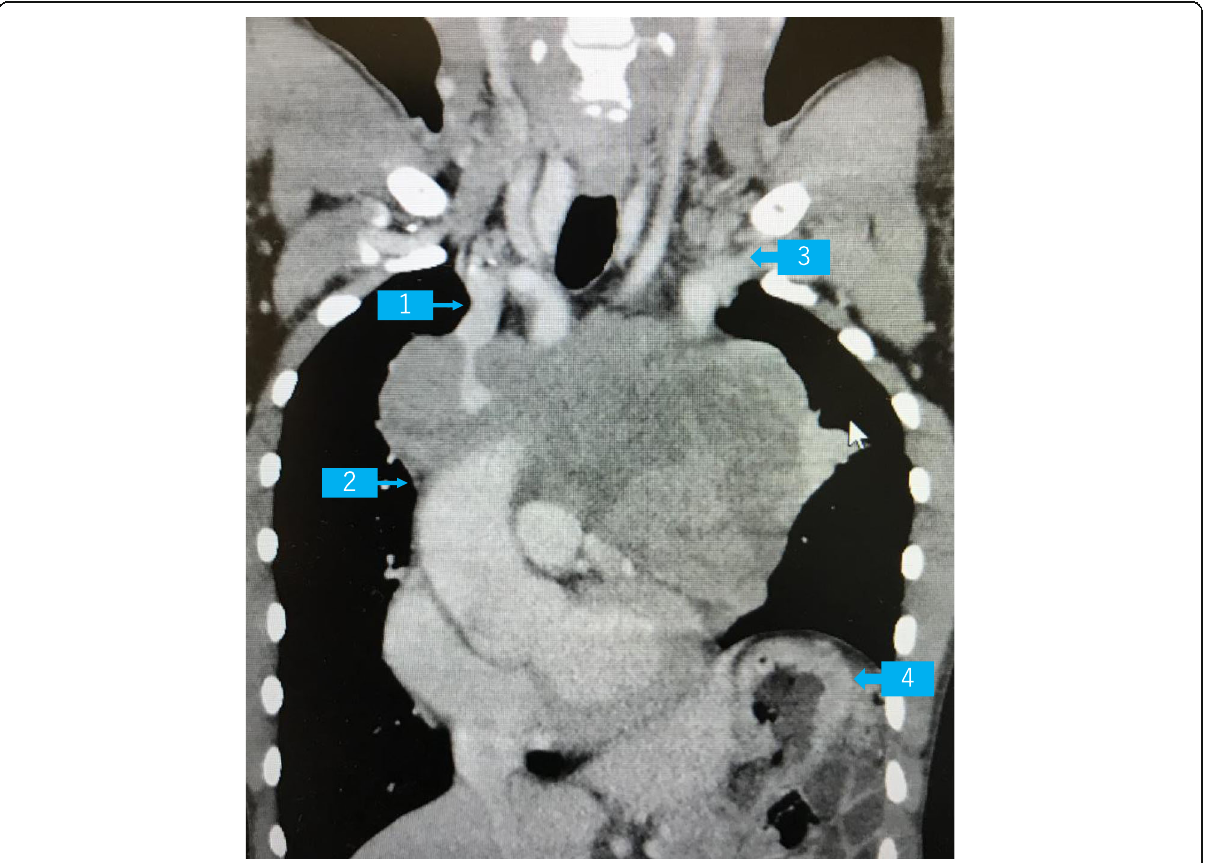
Fig. 2 CT scan showing the location of the giant anterior mediastinal tumor. Arrow 1, right innominate vein; arrow 2, superior vena cava (SVC); arrow 3, left innominate vein; arrow 4, elevated left